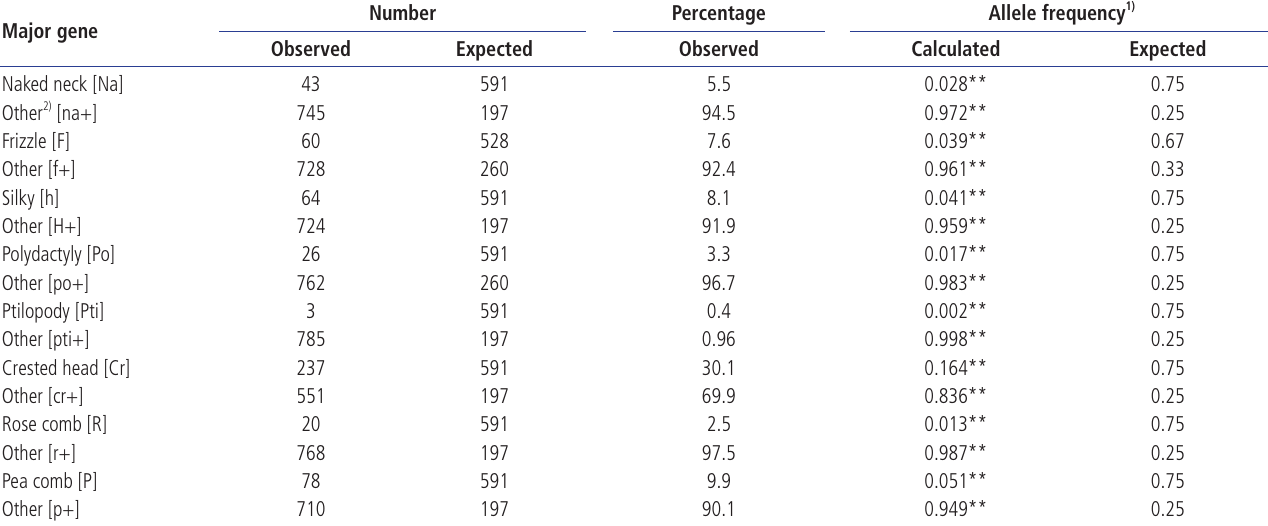
Table 1. Allele frequencies of major gene carriers in 788 local chickens Number Percentage Allele frequency 1) Major gene Observed Expected Observed Calculated